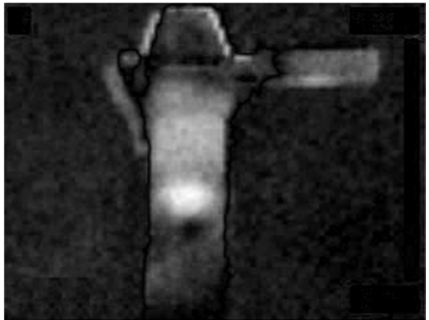
Figure 9. Difference of thermal images: | hag ‐ ag2b| , where hag − matrix (320 × 240) of the thermal image of the healthy angle grinder, ag2b − matrix (320 × 240) of the thermal image of the angle grinder with 2 blocked air inlets.